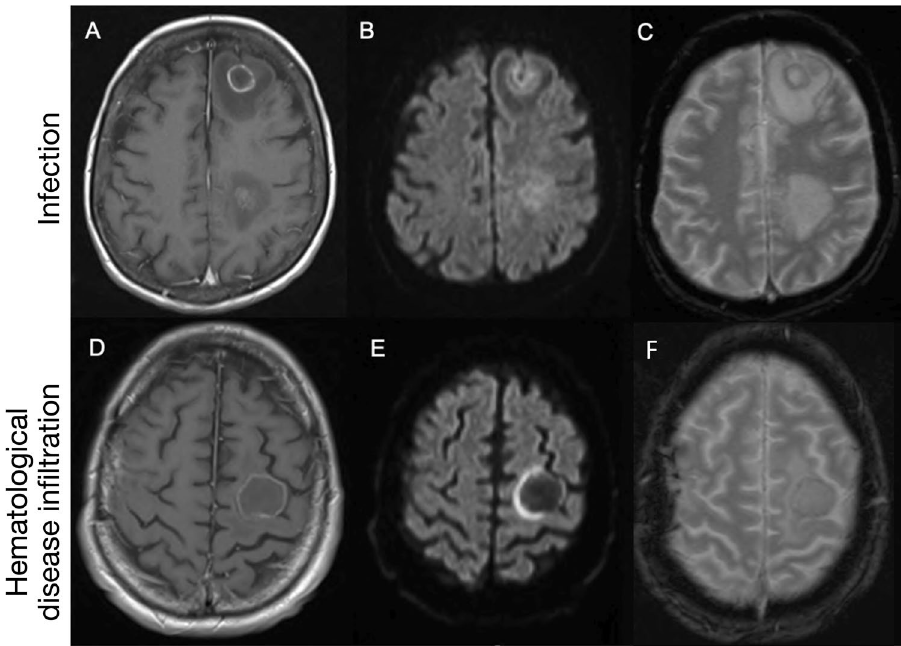
Figure 5. Case example of multivariate abnormality differentiation model. Cerebral aspergillosis in a patient with chronic lymphocytic leukemia ( A – C ) and secondary CNS lymphoma in a patient with DLBCL ( D – F ). Rim enhancing parenchymal lesions are demonstrated within the left frontal lobe in both cases ( A , D ) with peripheral restricted diffusion ( B , E ). The former is multifocal in distribution, whereas the latter is solitary. Peripheral hypointensity on T2* GRE ( C ) in the patient with cerebral aspergillosis is keeping with prior hemorrhage, whereas no evidence of hemorrhage was demonstrated in the case of DLBCL (not shown). CNS central nervous system, DLBCL diffuse large B-cell